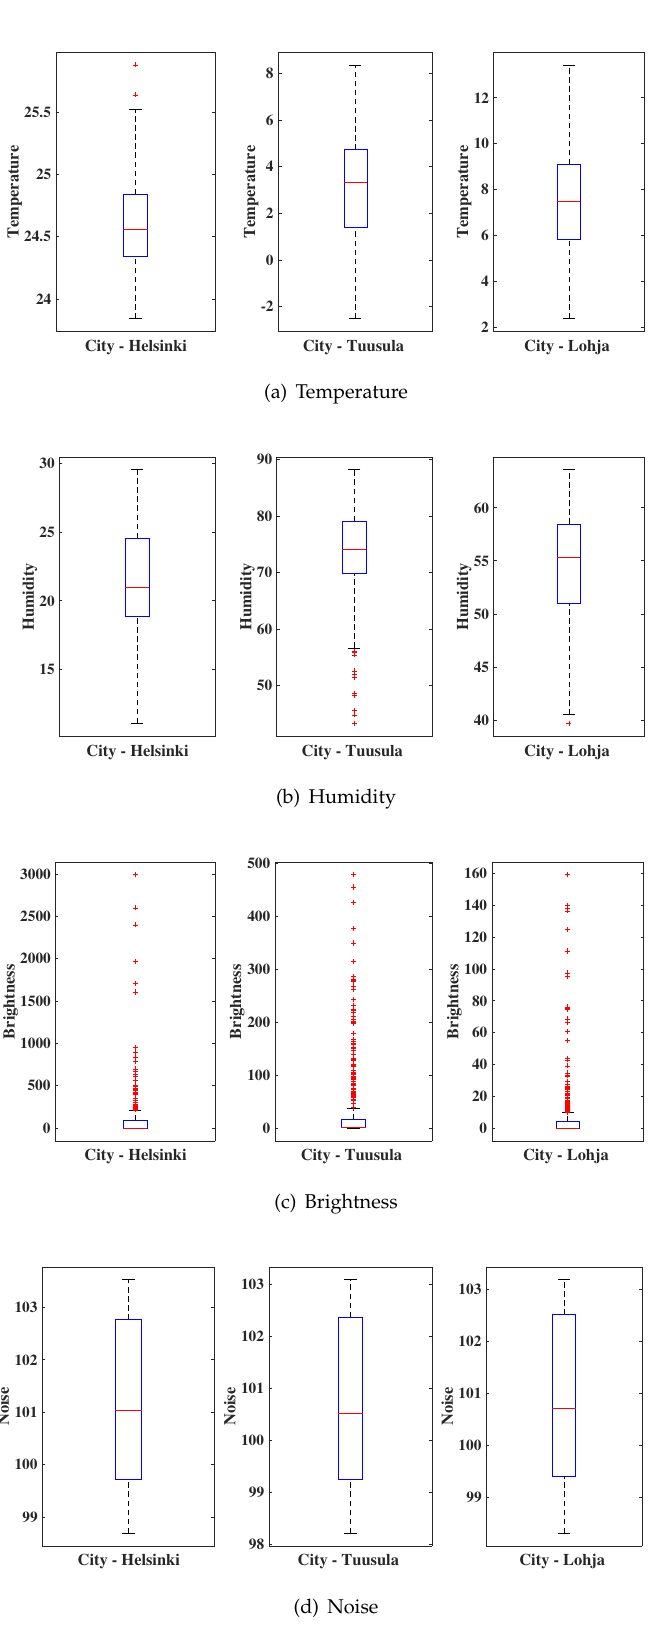
Figure 2. Time series of data